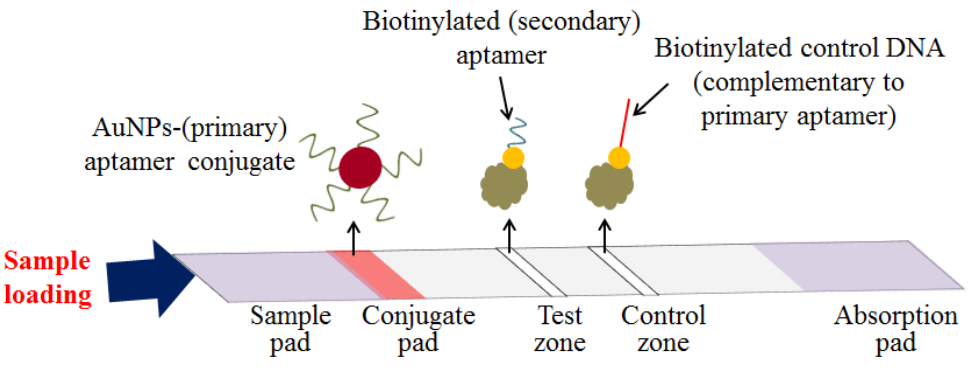
Figure 10. A schematic illustration of an AuNPs-based strip